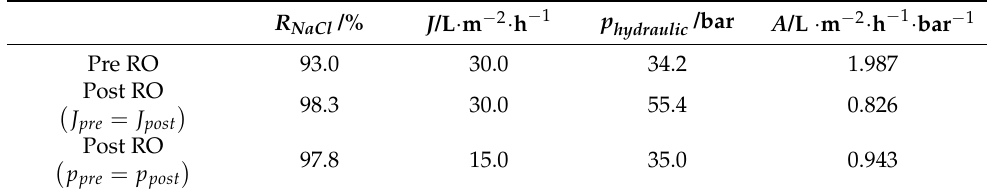
Table 3. Salt rejection, permeate flux, hydraulic pressure and membrane permeance before and after the RO experiment.